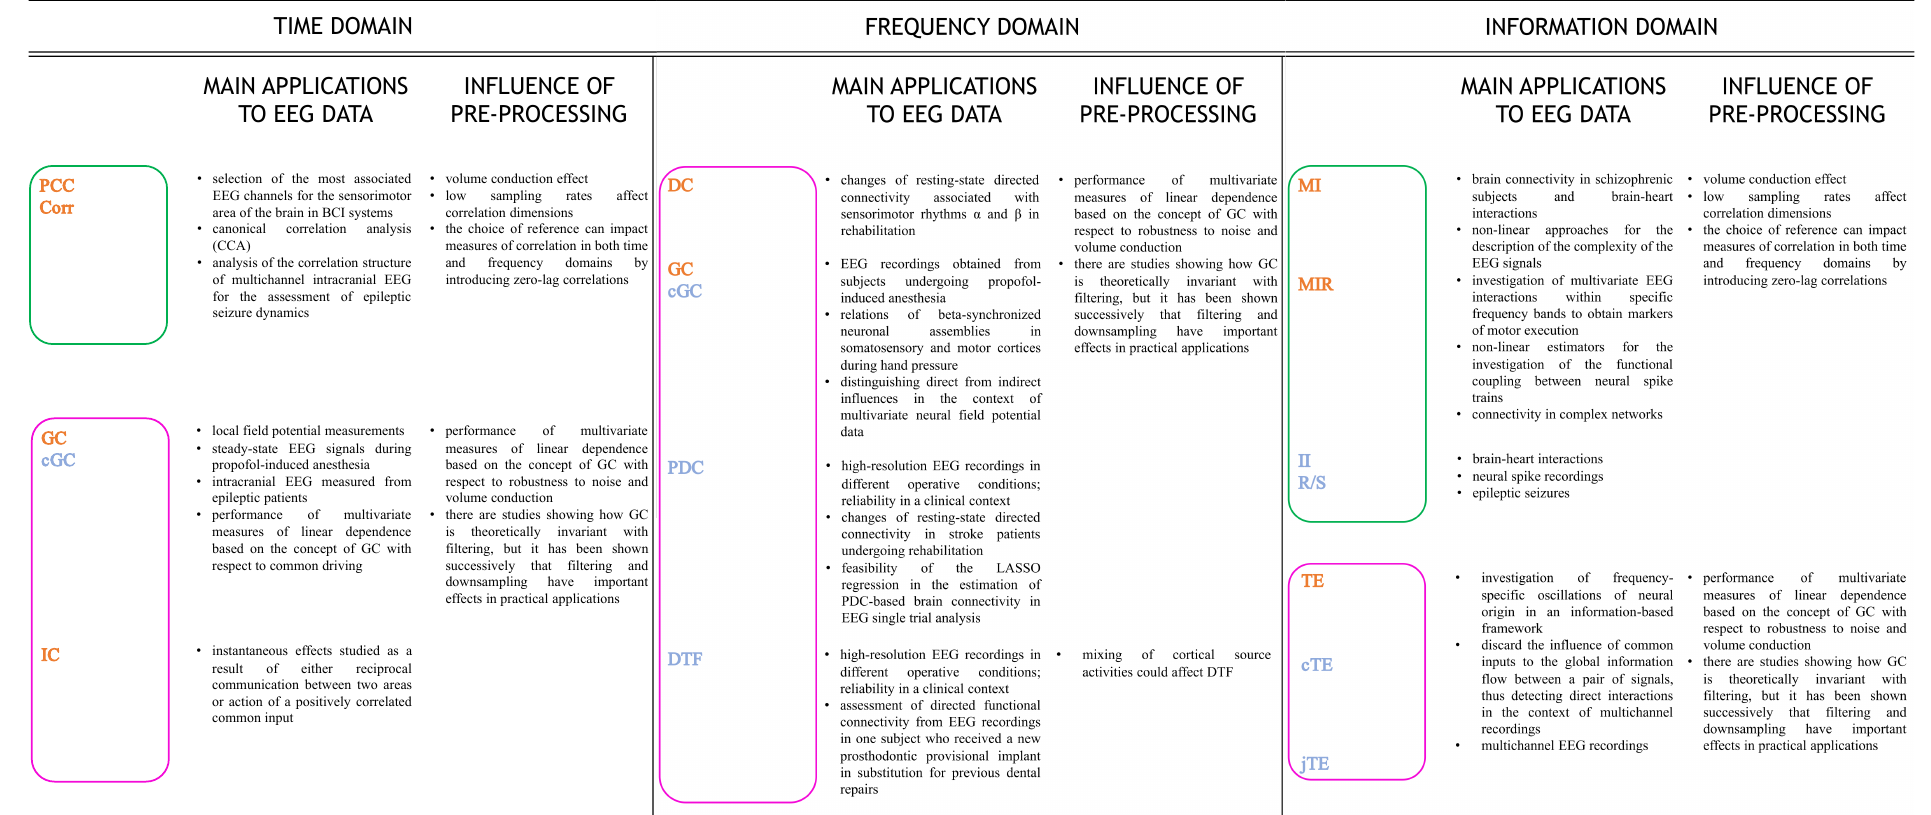
Figure 2. Most commonly used time-domain ( left ), frequency-domain ( middle ), and information-domain ( right ) measures of FC, divided into non-directed (green rectangles) and directed (purple rectangles) approaches, and into pairwise (orange) and multivariate (light blue) methods. For each domain, the main applications to EEG data are presented, along with the influence that pre-processing steps exert on them. References to the literature are provided for each metric, application, and impact of